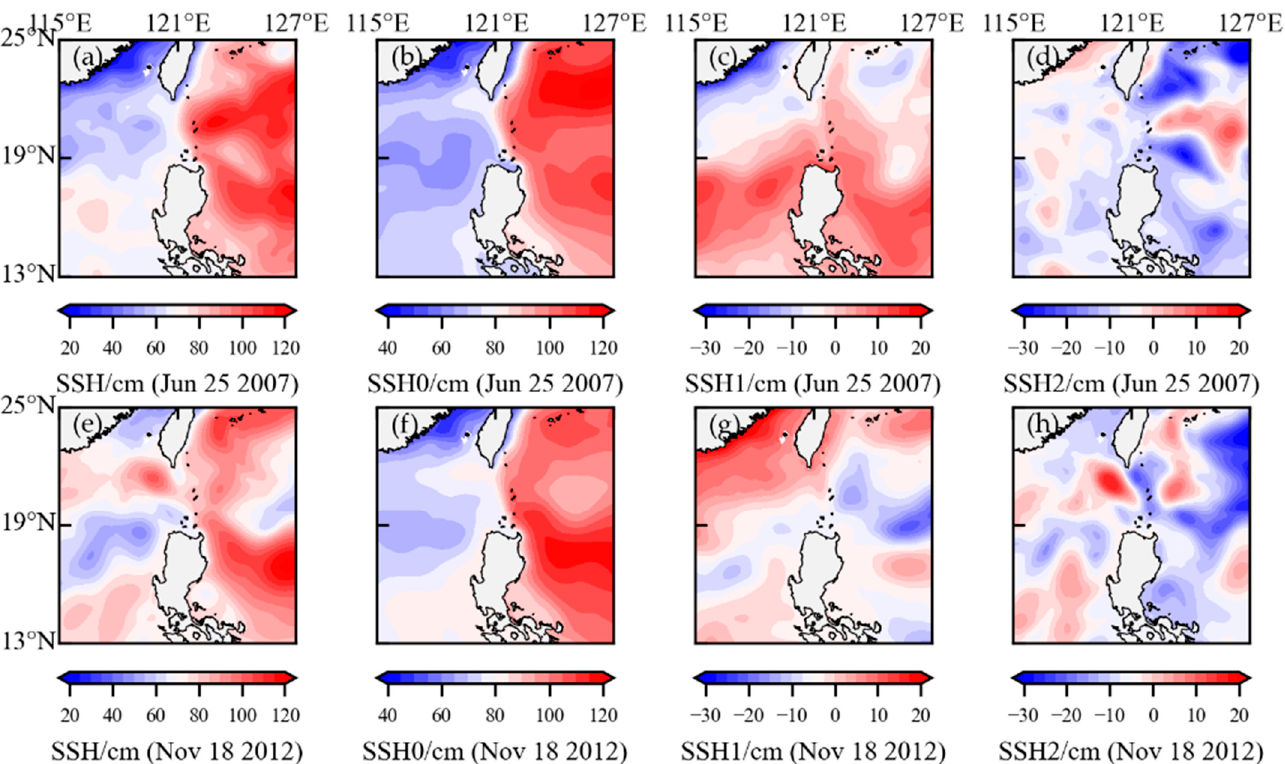
Figure 5. SSH snapshots (cm) on Jun 25, 2007 ( top ) and Nov 18, 2006 ( bottom ), with ( a , e ) the original SSH field; ( b , f ) the MWT climatological scale; ( c , g ) the seasonal scale; ( d , h ) the eddy scale.